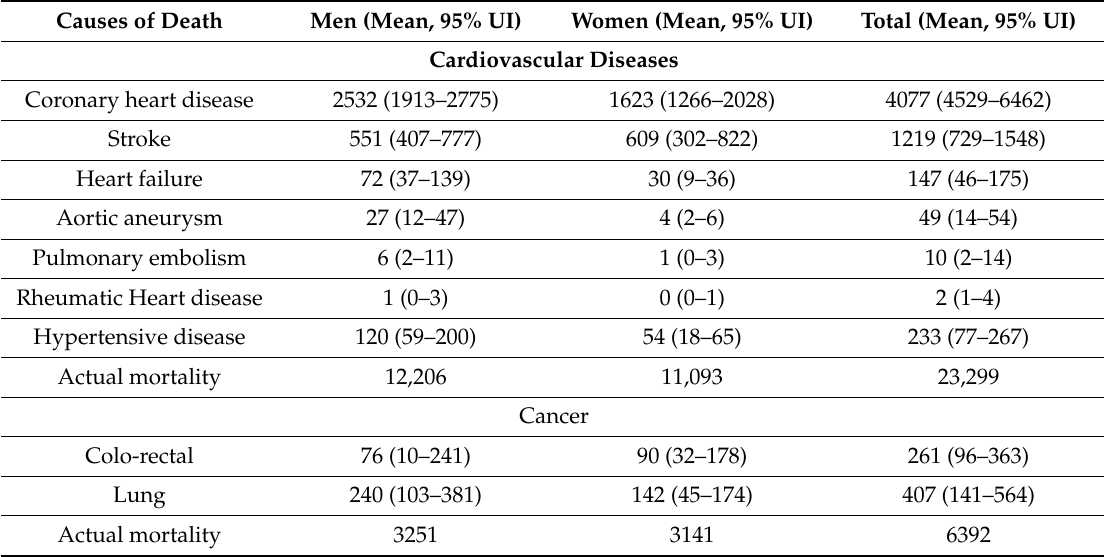
Table 3. Estimated numbers of deaths averted or delayed by cause if Swedish men and women adhered to dietary